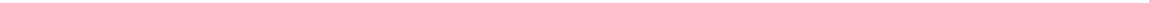
Fig. 1 Design and validation of the dual T H 2 cytokine sensor (DCS) device. a Schematic of the DCS. The two receptor subunits (IL-4R α and IL-13R α 1) of the IL-13 receptor (IL-13R) and the transcription factor STAT6 are expressed constitutively. Activation of the IL-13 receptor by IL-4 and/or IL-13 results in the activation of the JAK/STAT pathway, and the subsequent phosphorylation of STAT6 drives its dimerization and translocation to the nucleus. The STAT6 dimers bind to a STAT6-speci fi c operator, which is linked to a minimal promoter to control expression of either the SEAP or the IgE-binding protein DARPin E2_79. b Performance of the DCS device in different mammalian cell lines. HEK-293, HeLa, CHO-K1, hMSC, and HT-1080 were co-transfected with expression vectors encoding the IL-13R α 1 receptor subunit (pCH23, P hCMV - IL13RA1 -pA), the IL-4R α receptor subunit (pCH24, P hCMV - IL4RA -pA), the STAT6 transcription factor (pLS16, P hCMV - STAT6 -pA) and the SEAP reporter gene (pLS12, P STAT6/cEBP - SEAP -pA). * p < 0.05, two-tailed Student ’ s t -test. c DCS performance in the absence of heterologous expression of IL-13 receptor components and STAT6. 3 × 10 4 HEK-293 cells were transfected with the SEAP expression vector pLS12 (P STAT6/cEBP - SEAP -pA) and exposed for 48 h to different physiological cytokine concentrations (IL-4, IL-13, or both). d SEAP expression kinetics of the optimized DCS device in response to different cytokine concentrations. 3 × 10 4 HEK-293 co-transfected with pCH23 (P hCMV - IL13RA1 -pA) pCH24 (P hCMV - IL4RA -pA), pLS16 (P hCMV - STAT6 -pA) and pLS12 (P STAT6/cEBP - SEAP -pA) were cultivated for 48 h in the presence of different physiological cytokine concentrations (IL-4, IL-13, or both). e STAT6 is an essential component for DCS activity. 3 × 10 4 HEK-293 cells were co-transfected with pCH23 (P hCMV - IL13RA1 -pA), pCH24 (P hCMV - IL4RA -pA) and pLS12 (P STAT6/cEBP - SEAP -pA), and cultivated for 48 h in the presence of different physiological cytokine concentrations (IL-4, IL-13, or both). f IL-4 and IL-13 have no impact on the viability and metabolic integrity of the DCS-transgenic cell line. 3 × 10 4 HEK-293 cells were transfected with pSEAP2-Control (P SV40 - SEAP -pA) and exposed for 48 h to different physiological cytokine concentrations (IL-4, IL-13, or both). SEAP levels were assessed after 48 h in the culture supernatant. The data represent the means ±